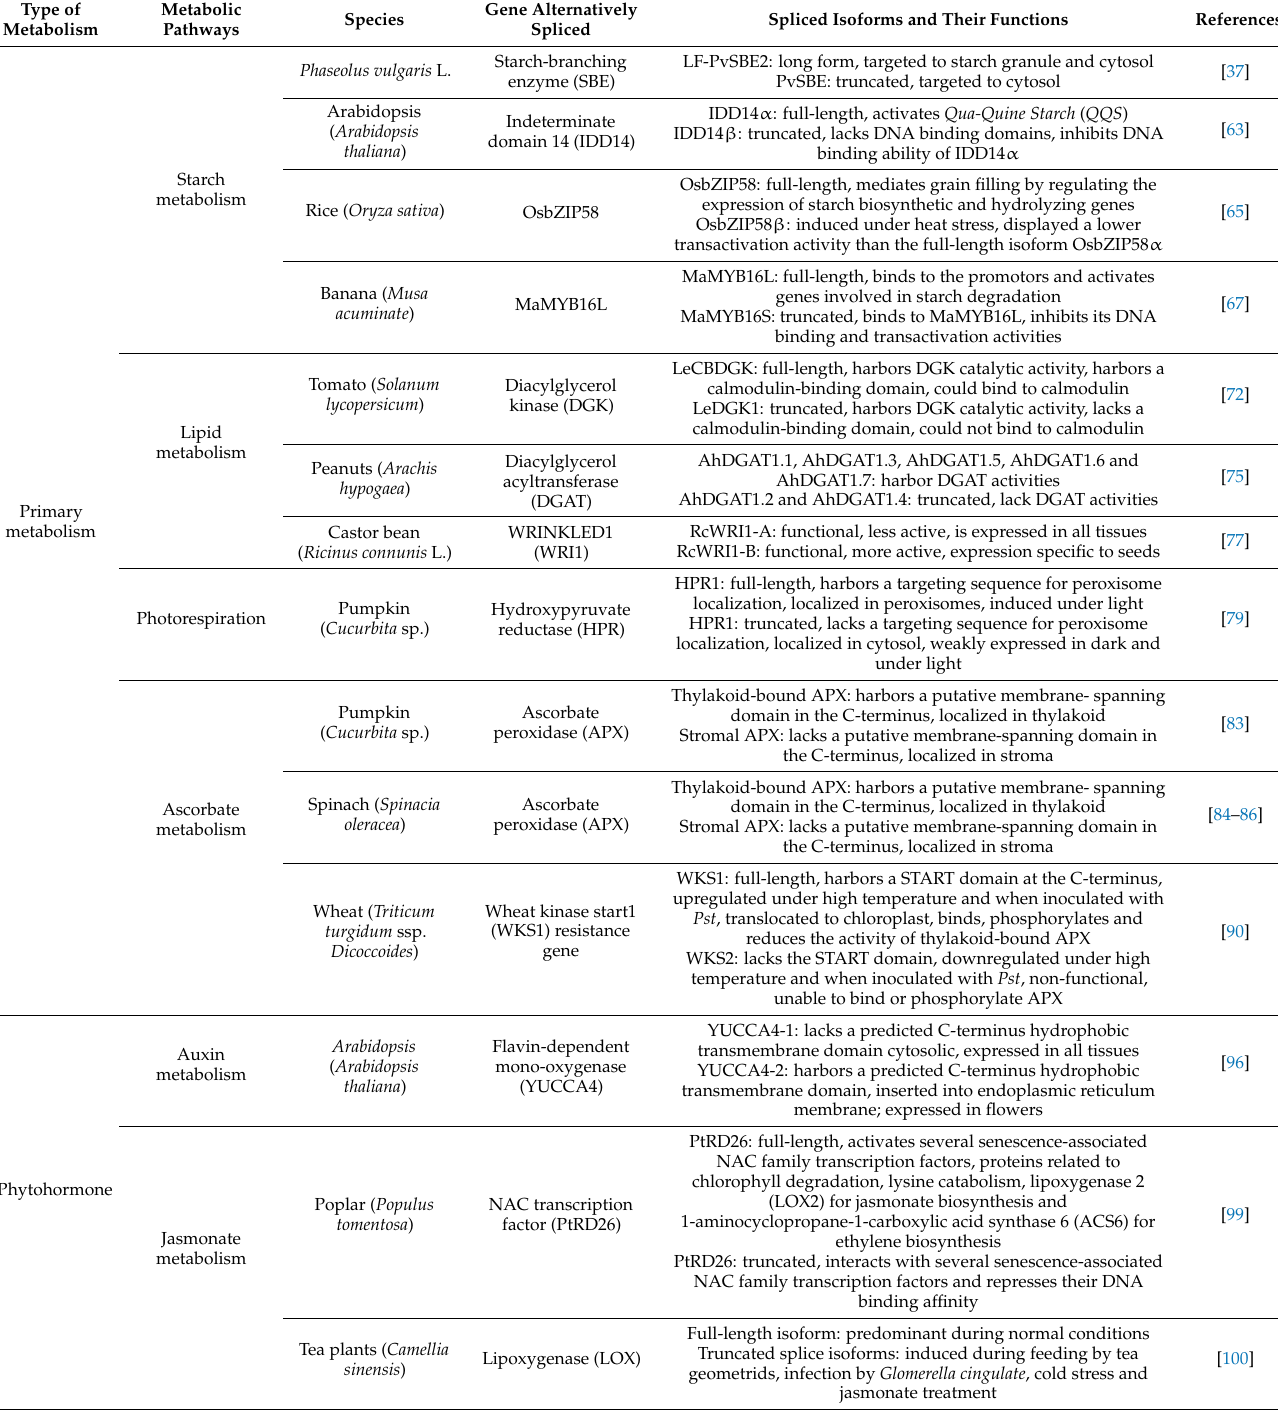
Table 1. Genes related to plant metabolism that are regulated by alternative